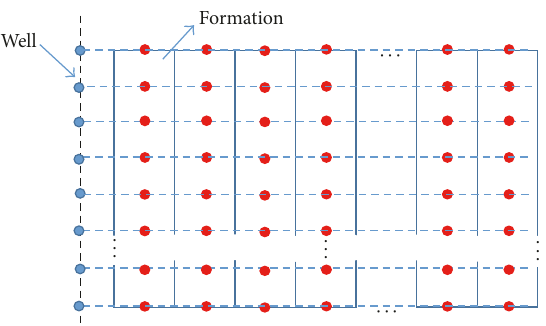
Figure 2: Grid for numerical calculation by using TOUGH2. The blue node is for the fluid and red node for the rock formation.